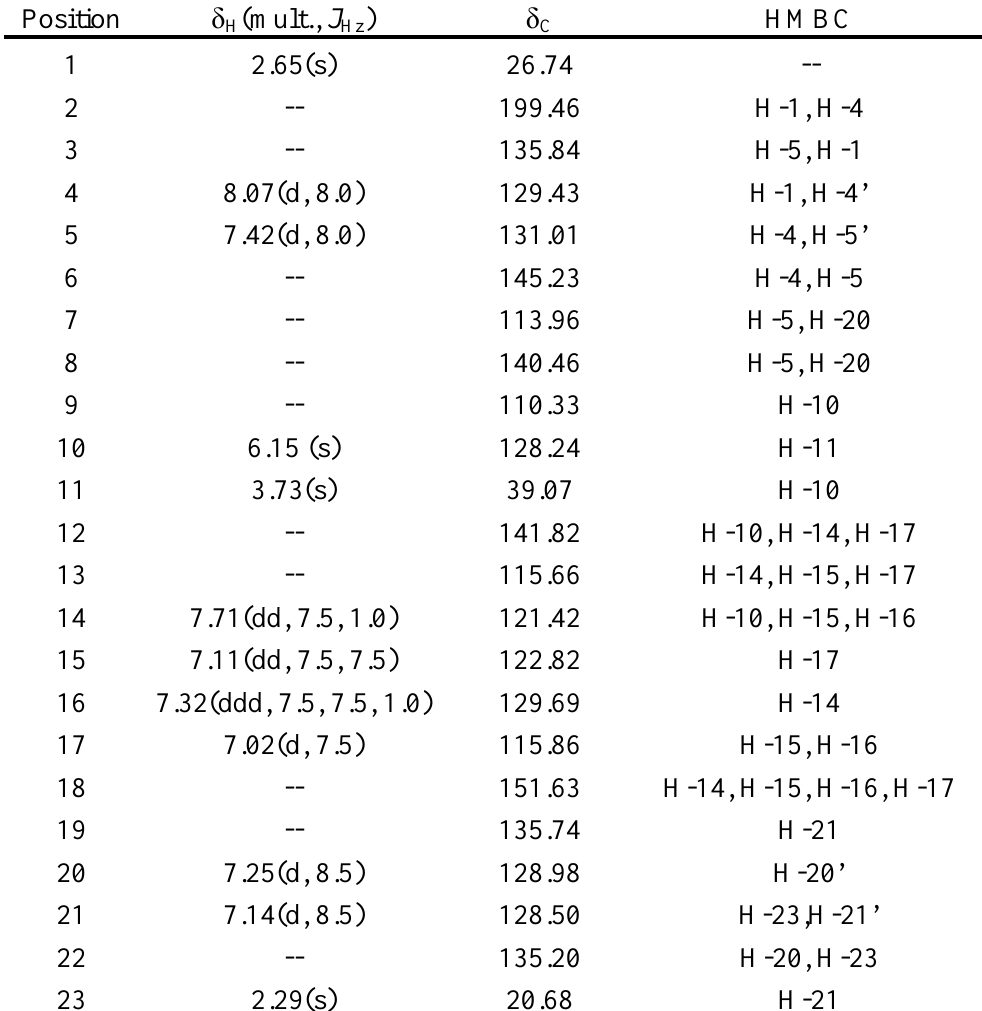
Table 1 1 H and 13 C assignments for compound B and HMBC